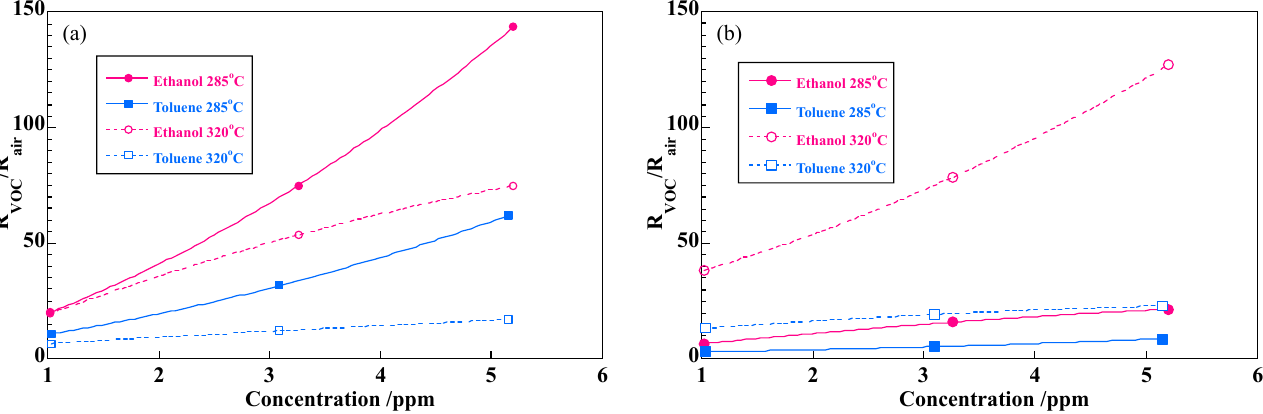
Figure 8. Concentration dependences of sensors responses ( R VOC / R air ) in ethanol and toluene: ( a ) sample A and ( b ) sample B at 285 and 320 °C.